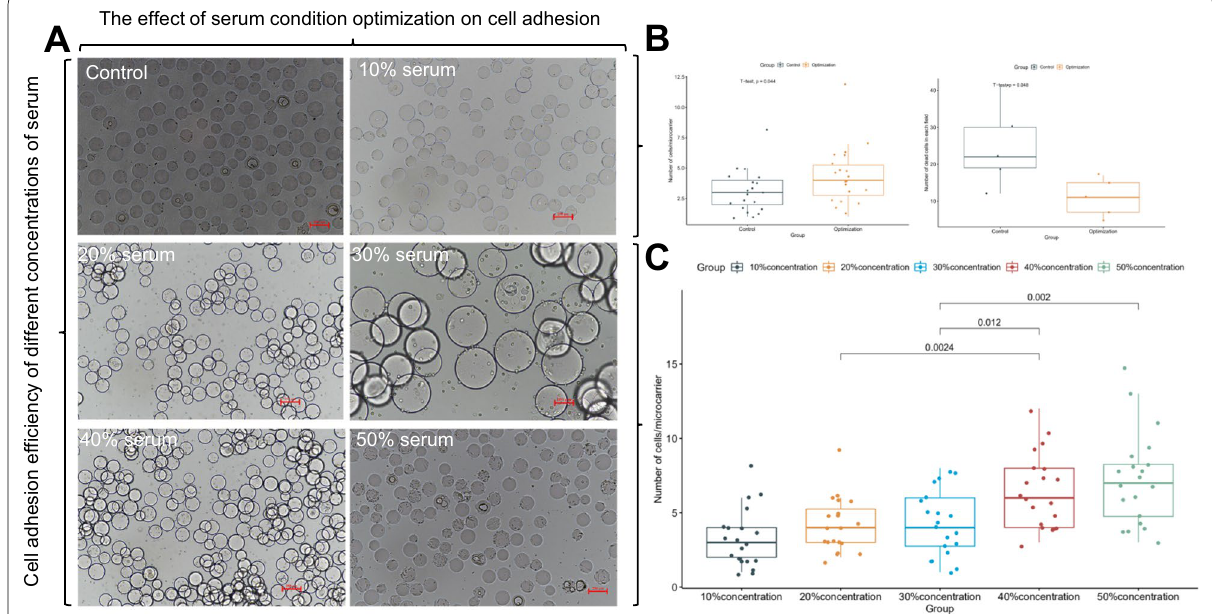
Fig. 2 Effect of serum condition optimization on cell adhesion. A Effect of serum-free, 10%, 20%, 30%, 40%, and 50% serum concentrations on the efficiency of cell attachment. B Comparison of the number of attached and dead cells between the optimized serum and control groups. C Difference in the number of cell attachments in media with different serum